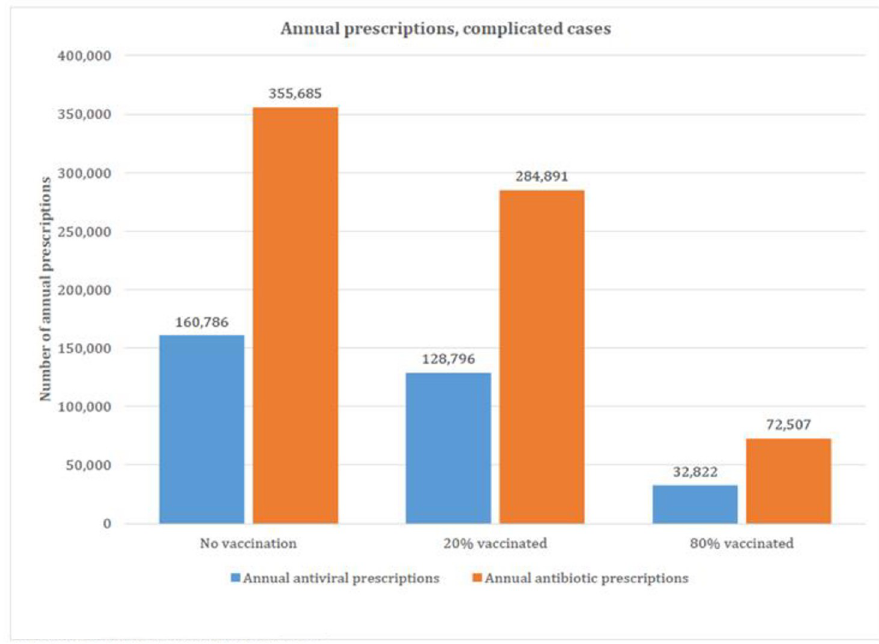
Fig 3. Estimated annual prescriptions (cases with complications), scenario analysis. � Total number of annual prescriptions. † Annual prescriptions avoided when compared to no vaccination scenario.